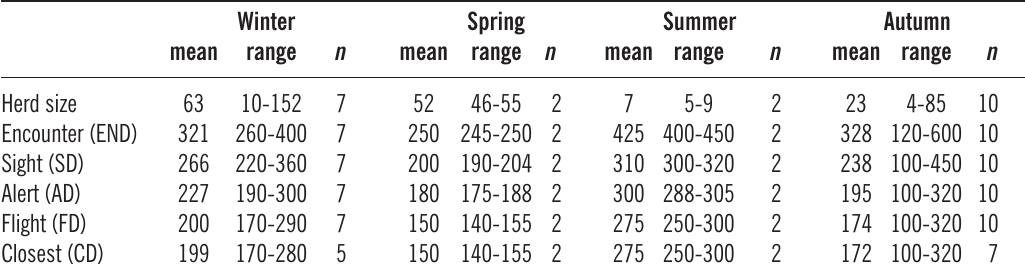
Table 5. Observed response distances of wild forest reindeer during different seasons when provoked by an observer on foot/snowshoes in 2010-12 (data pooled across years).